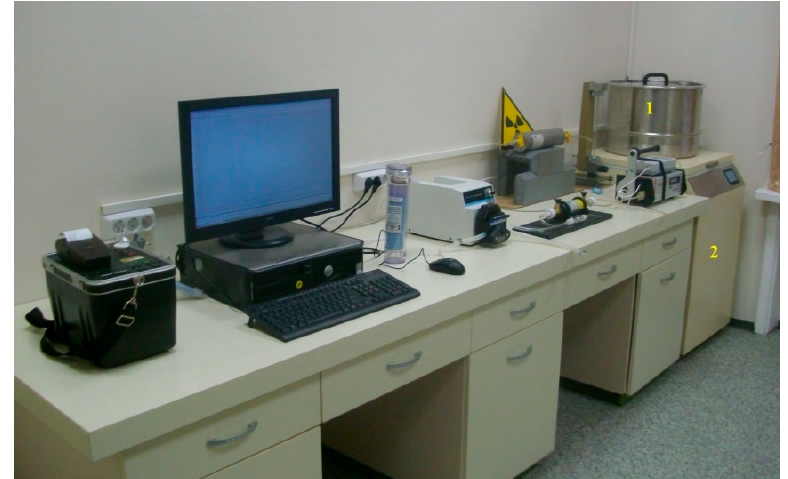
Figure 4. A photo of the exposure facility [9]. The detectors for calibration are placed in the 50 L exposure box (1) that is placed in the programmable thermostat (2).